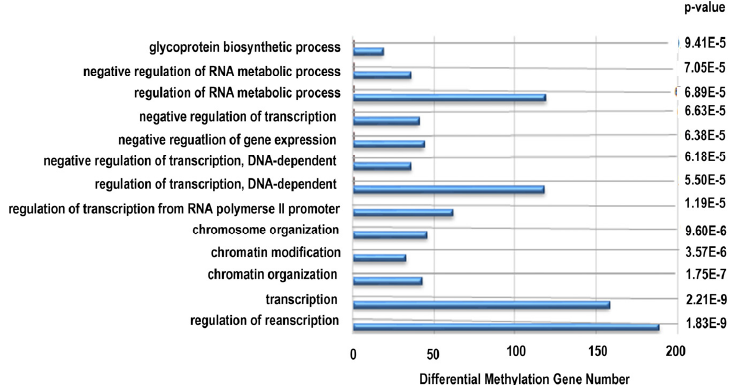
Figure 4. Gene ontology classifications in biology process for hypomethylated genes. The gene ontology (GO) term is on the y ‐ axis, number of genes is on the x ‐ axis, and the p ‐ value indicating significance of enrichment is on the right side.